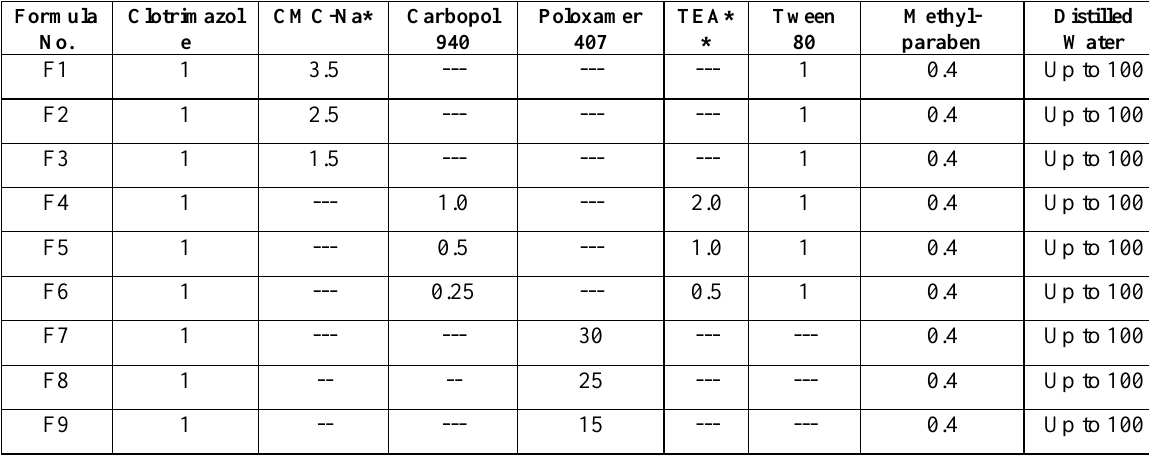
Table (1) Composition of clotrimazole vaginal hydrogels formulas (%w/w). * Sodium carboxymethyl